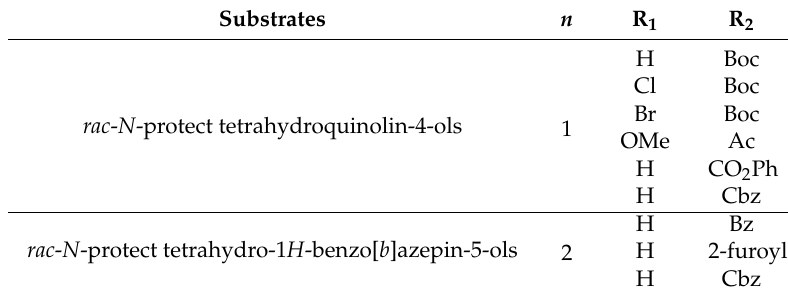
Table 4. Substrates used for the enzymatic kinetic resolution to produce tetrahydroquinolinol and tetrahydrobenzoazepinol derivatives [60].